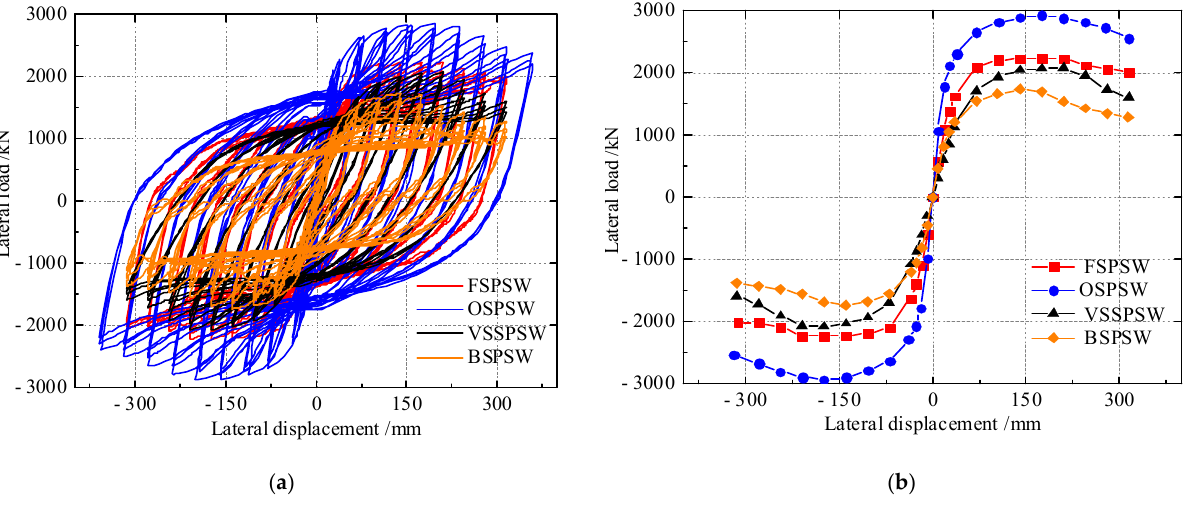
Figure 9. Load ‒ displacement curves of the FSPSW, OSPSW, VSSPSW, and BSPSW: ( a ) Hysteretic Figure 9. Load-displacement curves of the FSPSW, OSPSW, VSSPSW, and BSPSW: ( a ) Hysteretic curves; ( b ) Envelope curves. curves; ( b ) Envelope curves. Table 4. Characteristic results of the FSPSW, OSPSW, VSSPSW, and BSPSW. Table 4. Characteristic results of the FSPSW, OSPSW, VSSPSW, and BSPSW. Specimen K 0 / (kN/mm )